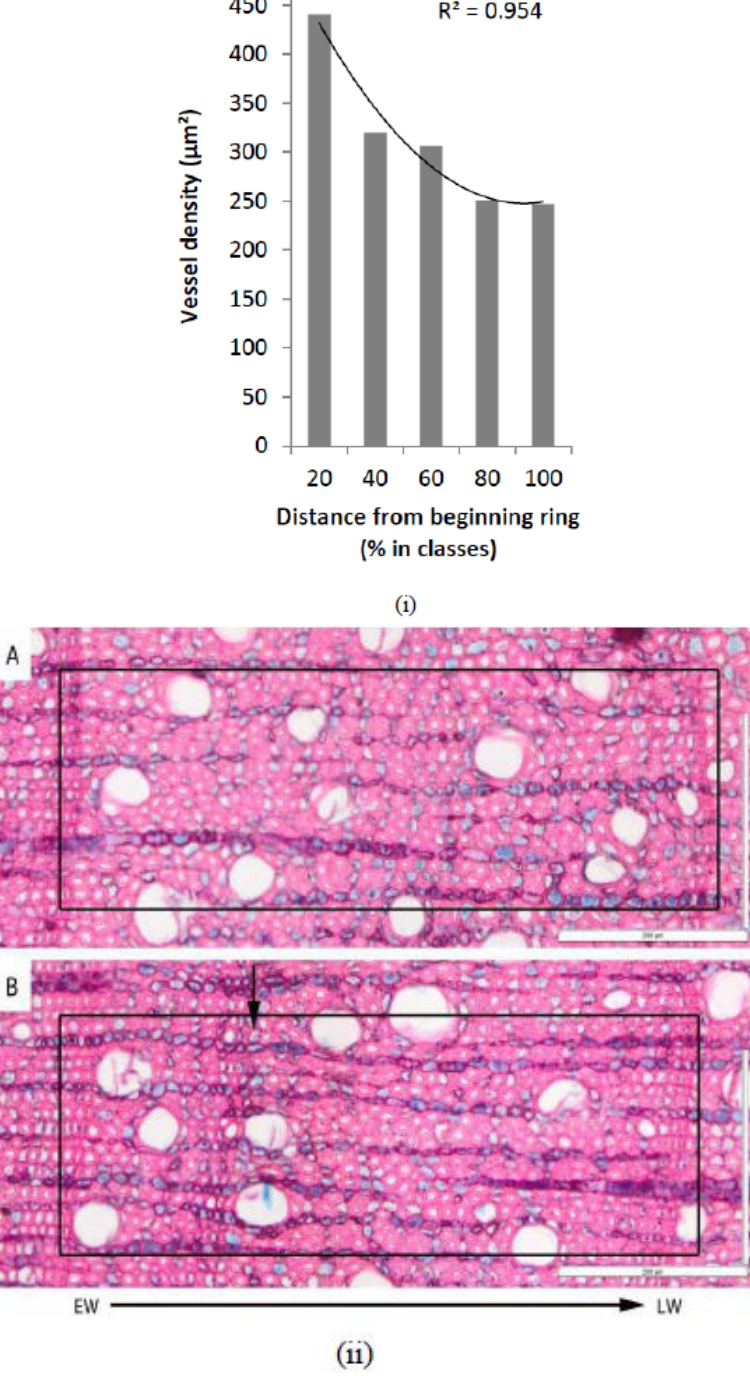
Figure 5. ( i ) Variability of the vessel density within a tree ring from the start (0%) to the end of a growth ring (100%), as derived from measurements of 50 tree rings. ( ii ) Microphotographs from sample Tw64881 showing a typical tree ring ( A ) without intra-annual density fluctuation (IADF) in 2011 and ( B ) with IADF in 2009. Figure composition was based on De Micco et al. [2]. The location of the IADF in B is indicated with a black arrow.